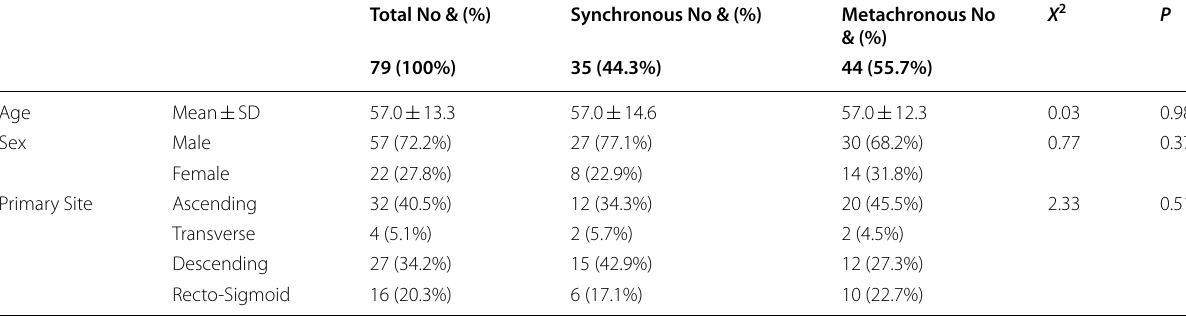
Table 1 Age, sex and site distribution status among the study population